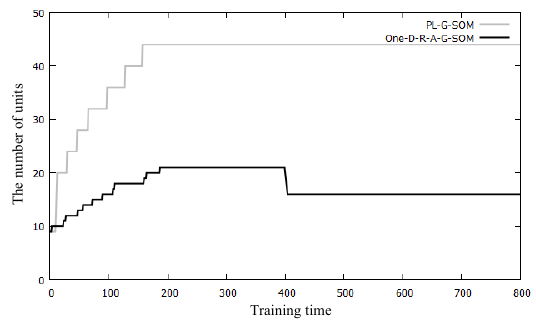
Fig. 9. Comparison of the change of number of units during training between different SOMs.